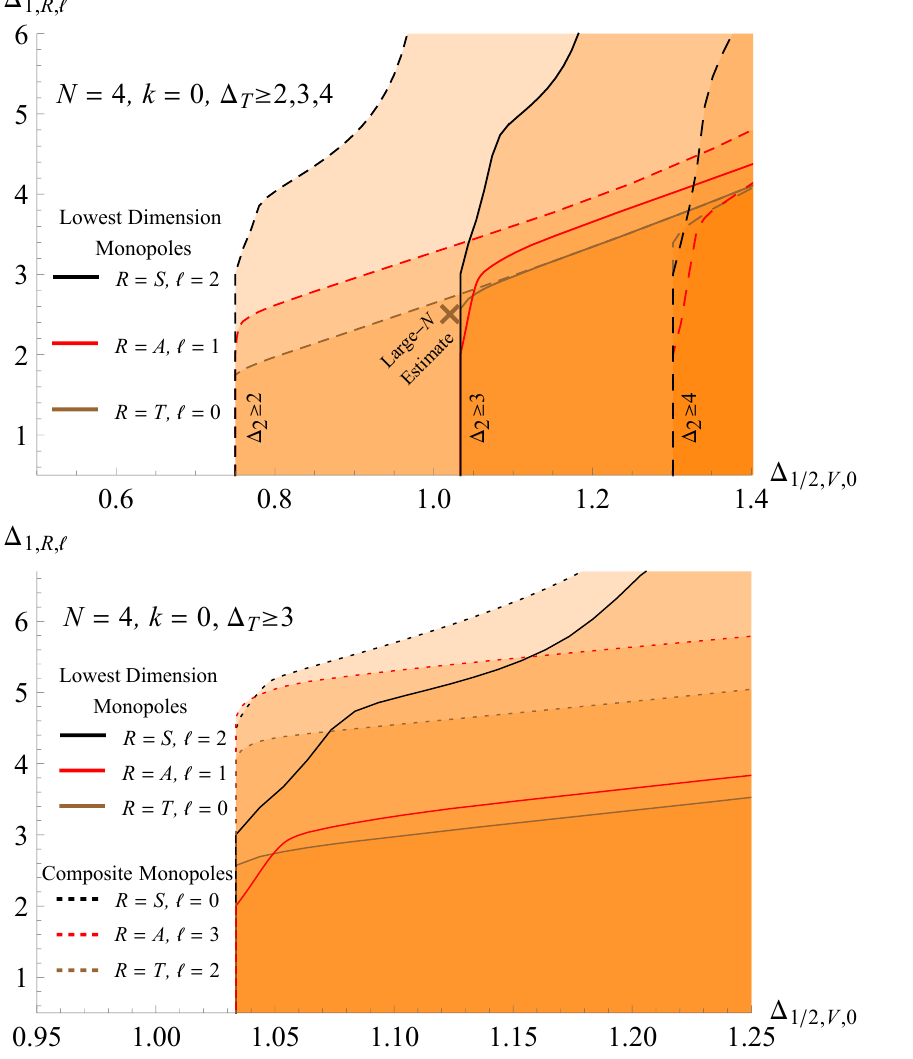
Figure 7 . Upper bounds on scaling dimensions (cid:1) 1 ;R;‘ of the lowest dimension q = 1 monopole operators in the singlet S (brown line), antisymmetric A (red line), and traceless symmetric T (black line) irreps of SO(6) (cid:24) = SU(4) in terms of the scaling dimension (cid:1) of the lowest dimension 1 = 2 ;V; 0 q = 1 = 2 monopole operator in the vector V irrep with a gap imposed on the lowest q = 0 irrep T scaling dimension (cid:1) T . Top : the lowest dimension monopoles, with spins 0 ; 1 ; 2 for T; A; S respectively, for gaps (cid:1) T (cid:21) 2 ; 3 ; 4, where the brown cross denotes the large N expansion values of ( N (cid:1) (0) + (cid:1) (1) ; N (cid:1) (0) + (cid:1) (1) ) determined in [19, 20]. Bottom : for (cid:1) T (cid:21) 3, the next to lowest 1 1 1 = 2 1 = 2 dimension monopoles in each sector, with spins 2 ; 3 ; 0 for T; A; S respectively. These bounds were computed with the numerical bootstrap parameters j max = 25 and (cid:3) = 19, for details on their meaning see